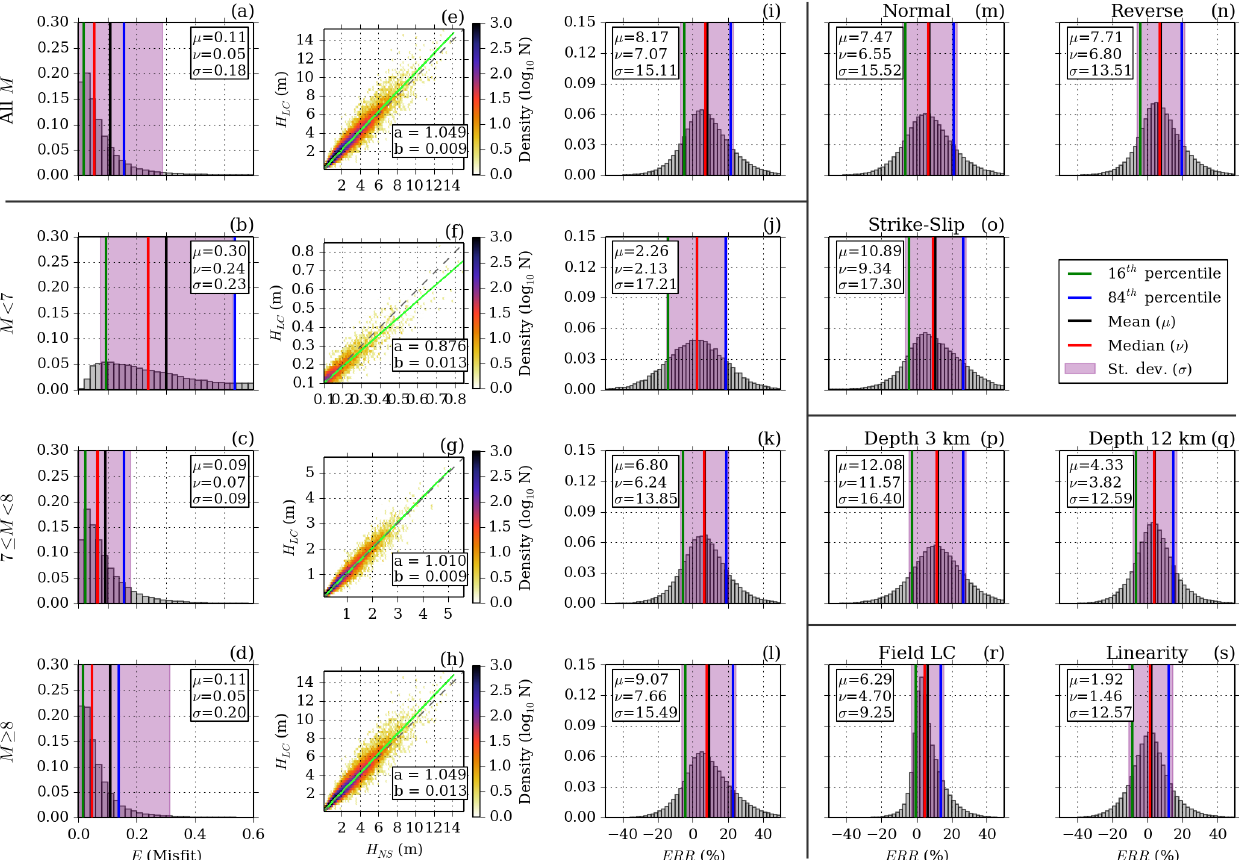
Figure 3. Validation results: (a) misfit between the considered LC and NS waveforms; (b–d) misfits grouped by earthquake magnitude; (e–h) scatter plots between LC and NS tsunami maxima; (i) LC percentage error with respect to NS; (j–l) percentage errors grouped by earthquake magnitude; (m–o) percentage errors grouped by faulting mechanisms; (p–q) percentage errors grouped by top-of-the-fault depths; (r) NL percentage error with respect to NS; (s) LC percentage error with respect to NL.